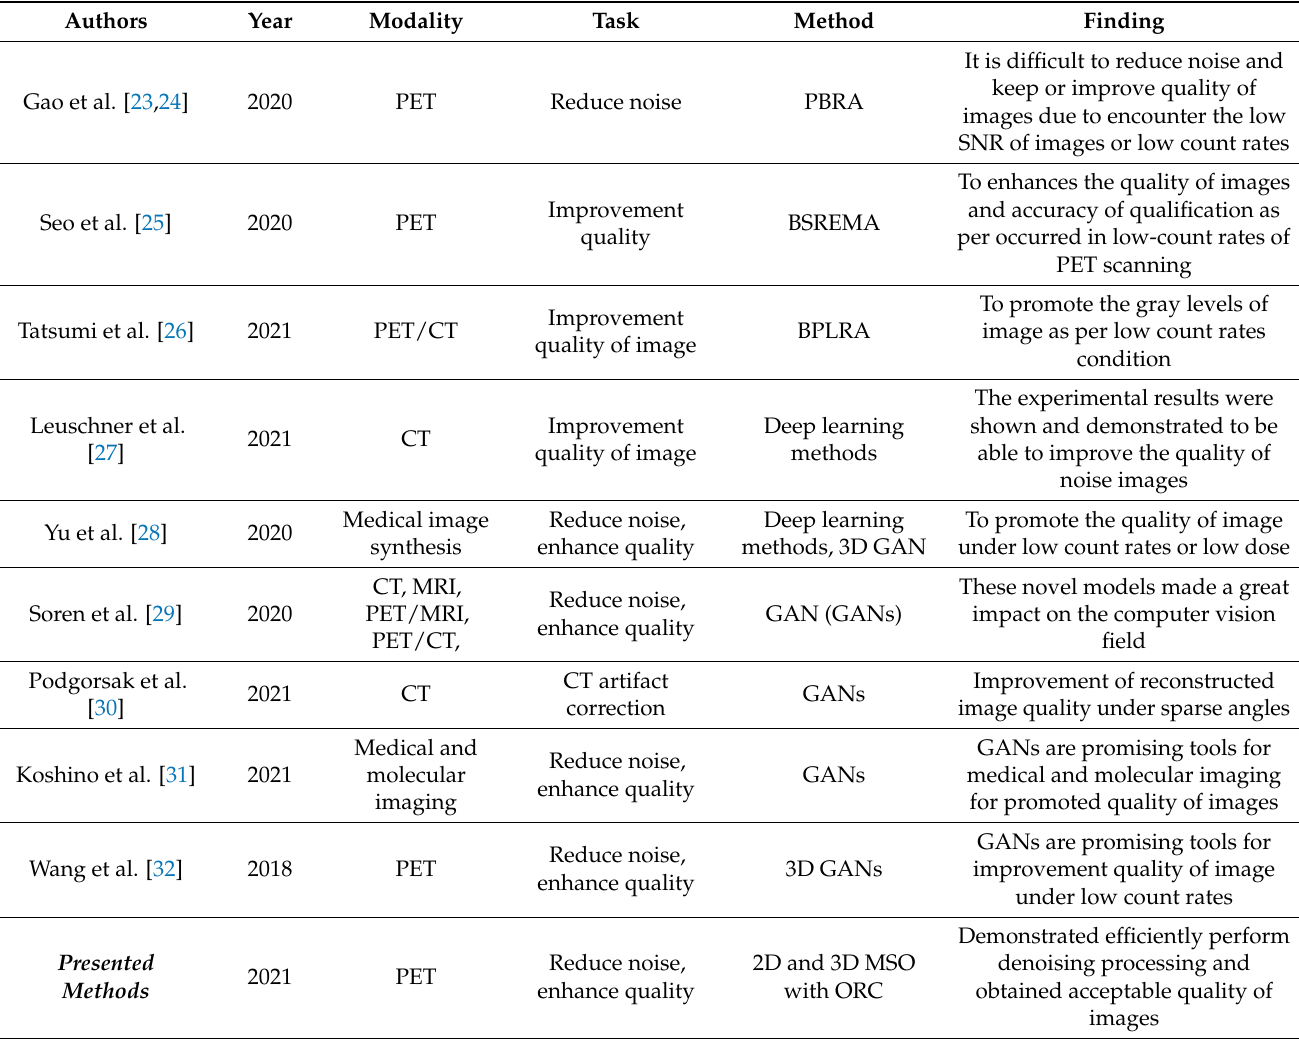
Table 6. The comparisons among published literature with the presented